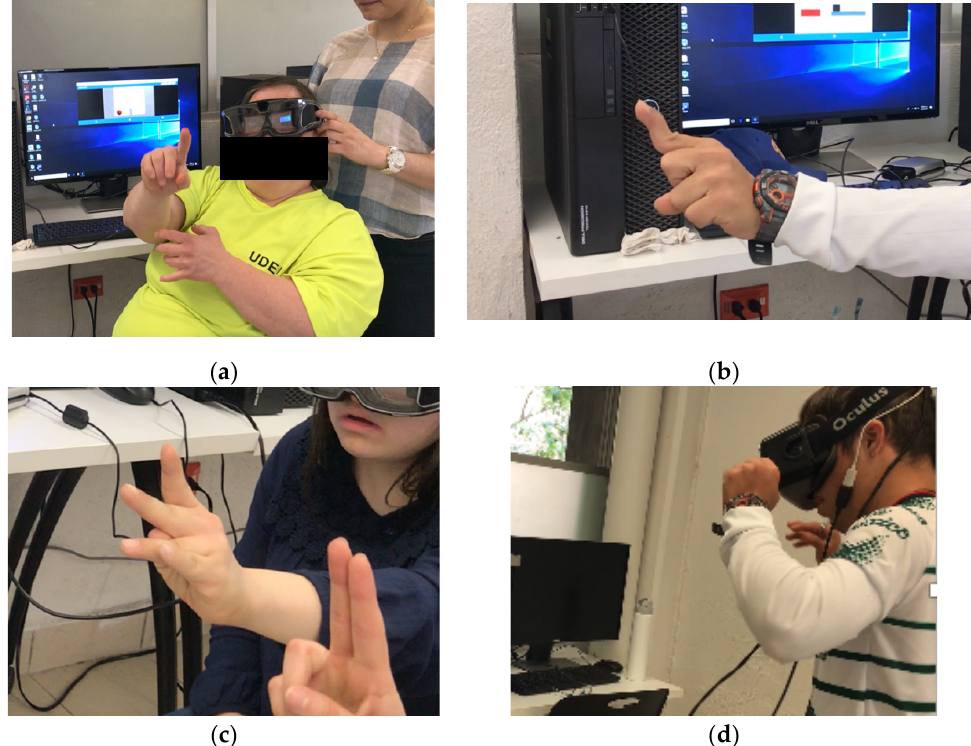
Figure 2. Problems generated by physiological traits. ( a ) Image of user whose glasses have slipped. ( b ) Example of angle of finger joints in users with DS. ( c ) User attempting Pan gesture. ( d ) User complaining of dizziness removing Oculus Rift.